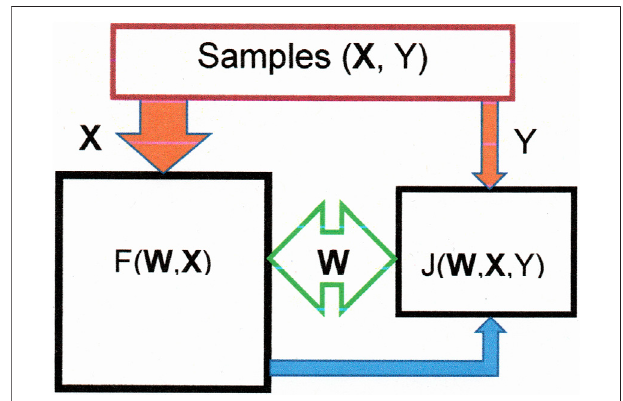
FIGURE 1 | Sketch representing a learning machine. F(W, X), fed with the variable X, is represented by the left square. Its output (blue arrow) provides the right square, together with the variable Y, to form the error function, J(W, X, Y), during training . The parameters W are modi fi ed in this square to bring the function F(W, X) up to